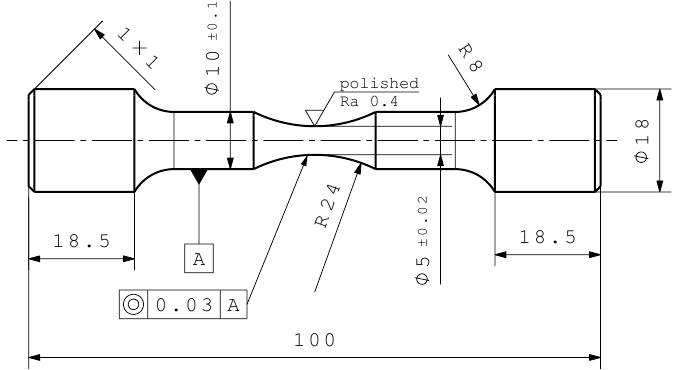
Figure 1. Specimen geometry for high-cycle fatigue testing